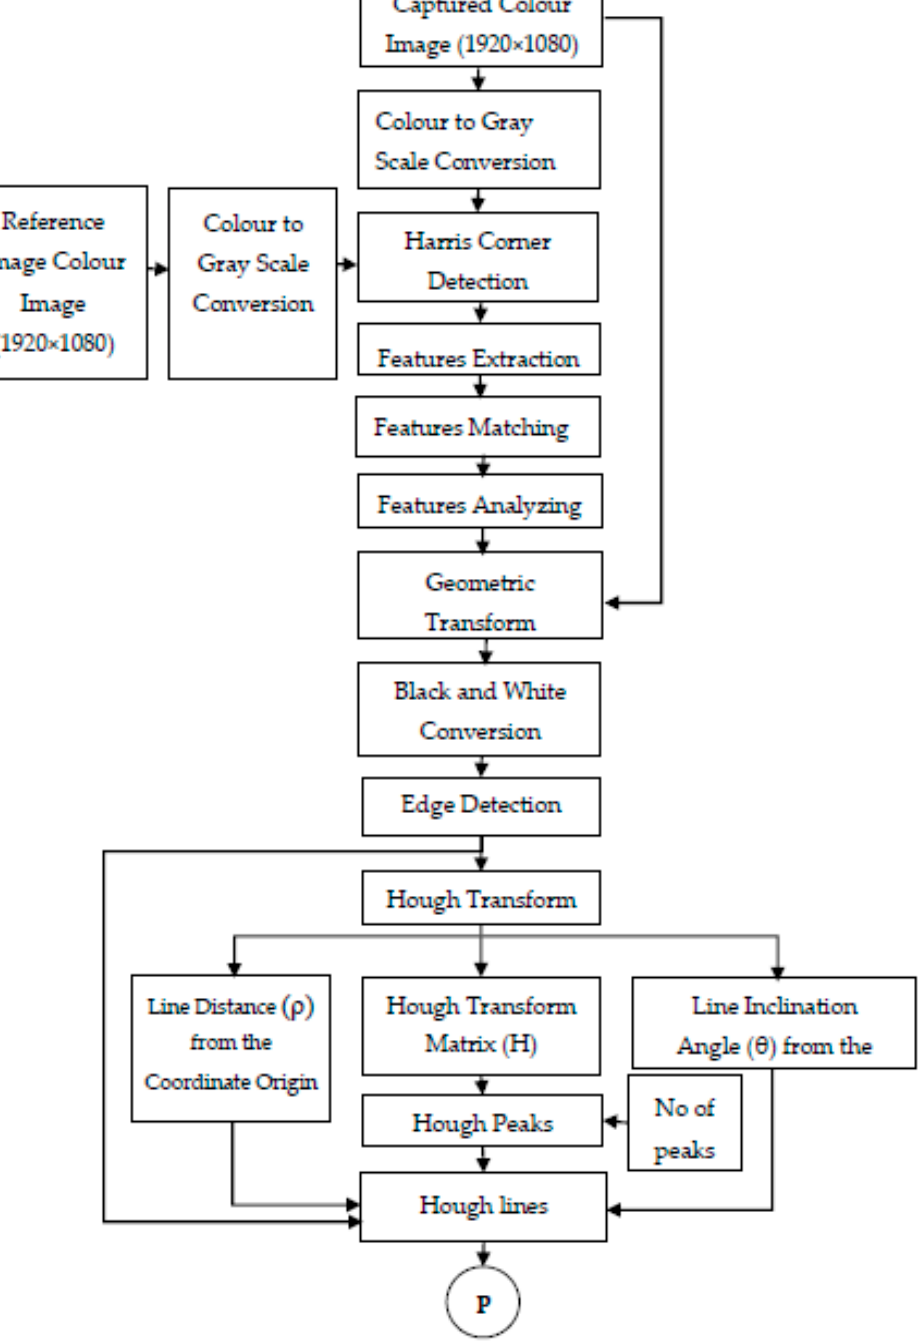
Figure 7. Flowchart representation for display screen extraction.